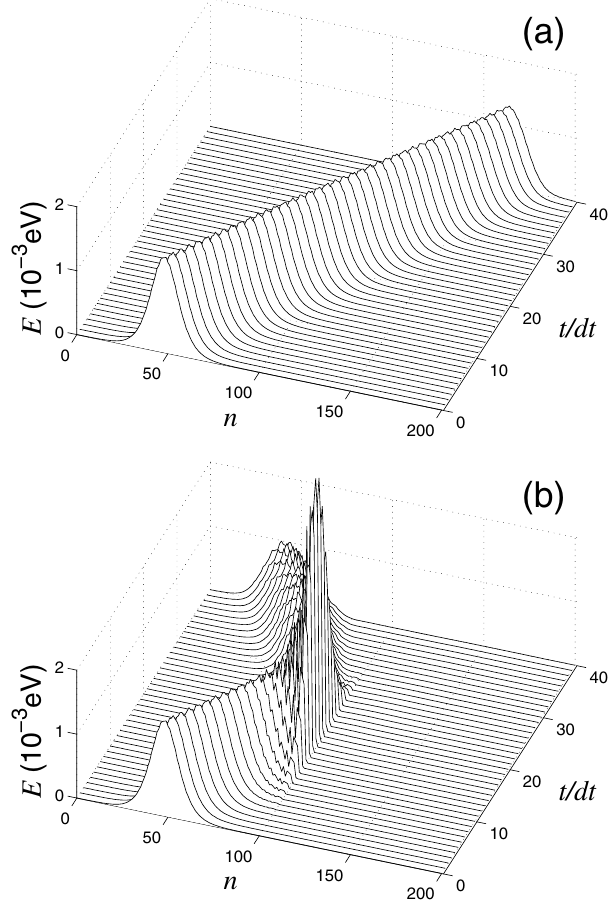
Figure 6. Propagation of a wavepacket of the in-plane phonons in ( a ) ideal nanoribbon and ( b ) nanoribbon with the double vacancy V 2 (585) (nanoribbon width D = 1.23 nm) for wave number q = 0.6 π , frequency ω ( q ) = 1569.3 cm − 1 (the wavepacket amplitude A = 0.0003 Å). Shown is the energy distribution at different time values t along the nanoribbon ( n is the number of the elementary unit cell), time step dt = 0.15 ps. Transmission coefficient T ( ω , q ) =